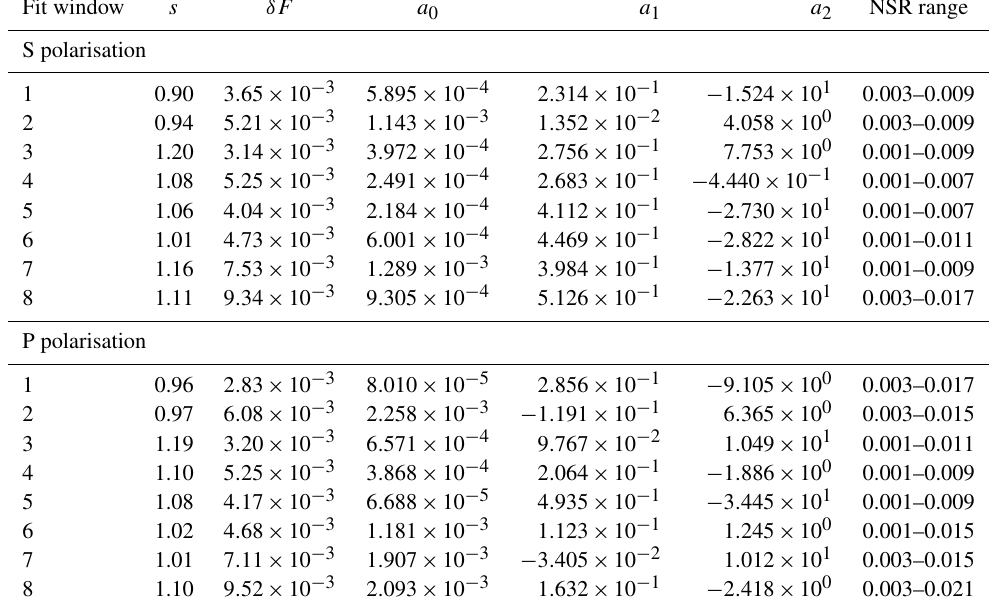
Table 7. Parameters of the GOSAT-2 noise model.